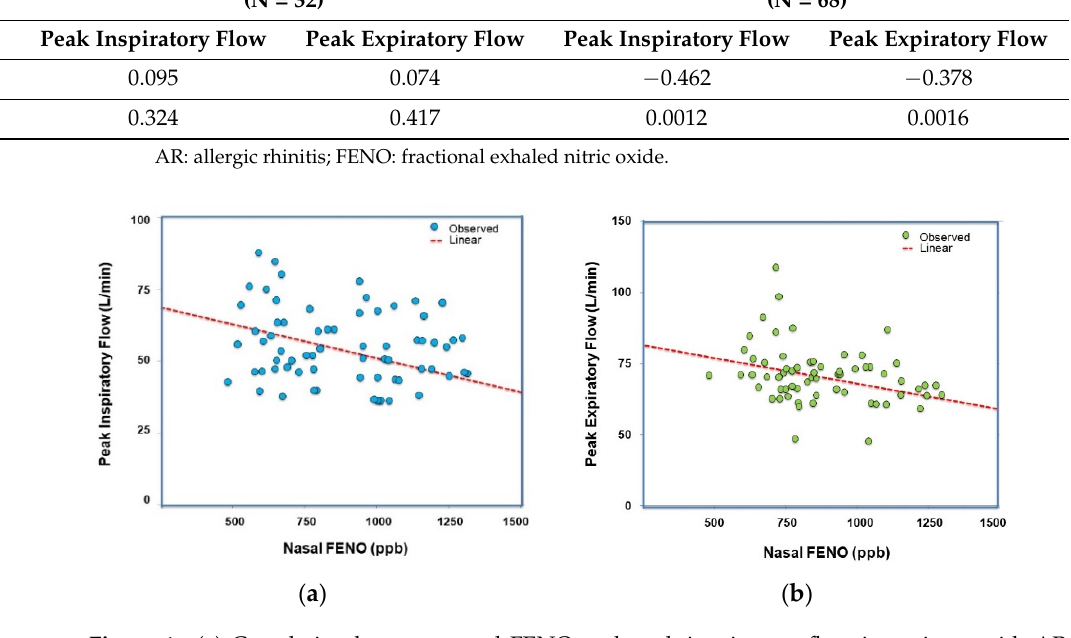
Table 2. Correlation between nasal FENO and the anthropometric characteristics of the control subjects and with clinical symptoms in patients with AR.